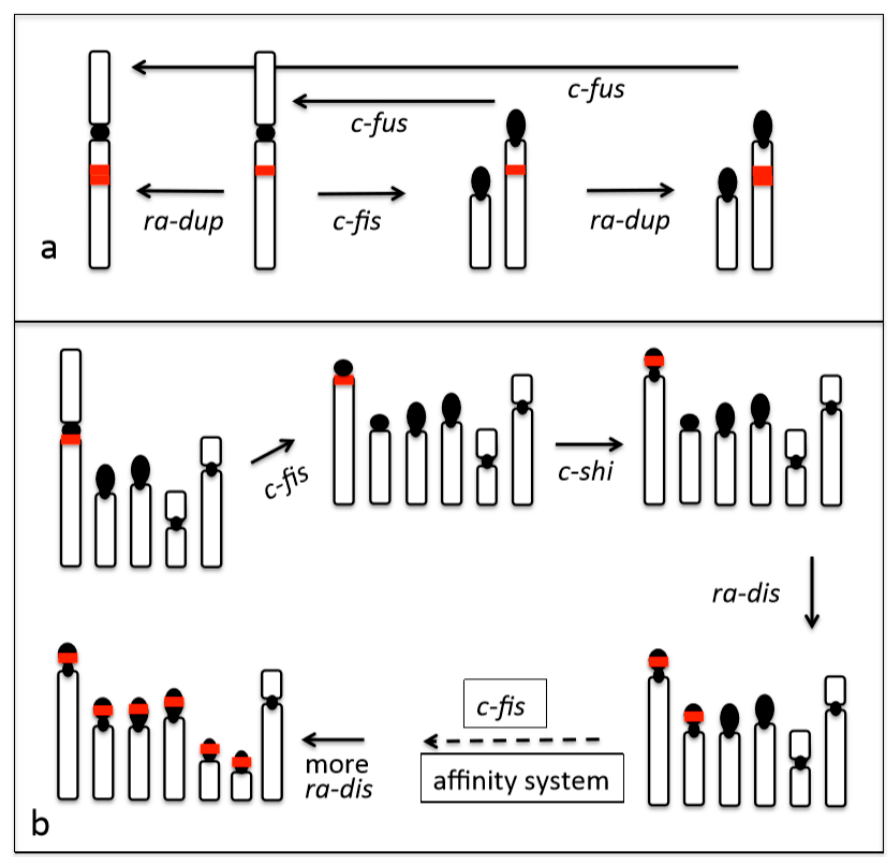
Figure 2. Plausible pathways of chromosome evolution and accompanied dispersion of rDNA. ( a ) rDNA located at an intercalary site in a chromosome arm. ( b ) rDNA located in a constitutive heterochromatin block close to the centromere. c-fus : centric fusion. c-fis : centric fission. ra-dup : duplication of rDNA array. c-shi : centromere shift. ra-dis : dispersion of rDNA array. affinity system: affinity among rDNA and other repeat arrays. Red blocks represent rDNA arrays. Black blocks represent constitutive heterochromatin. Black circles represent centromeres. Arrows indicate direction of chromosome change. See the text and [47] for the details.